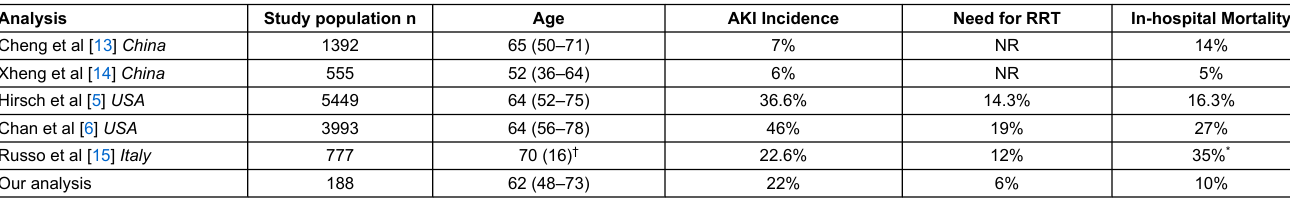
Table 3: Data on acute kidney injury in patients with COVID-19 from different